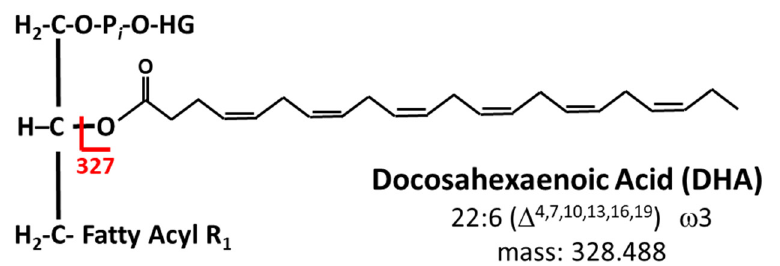
Figure 2. Targeted lipidomics permits the selective targeting of DHA containing phospholipids by conducting precursor ion scans in the negative ion mode for the m / z value that corresponds to the conducting precursor ion scans in the negative ion mode for the m/z value that corresponds to the molecular weight of DHA, m / z molecular weight of DHA, m/z 327.4.